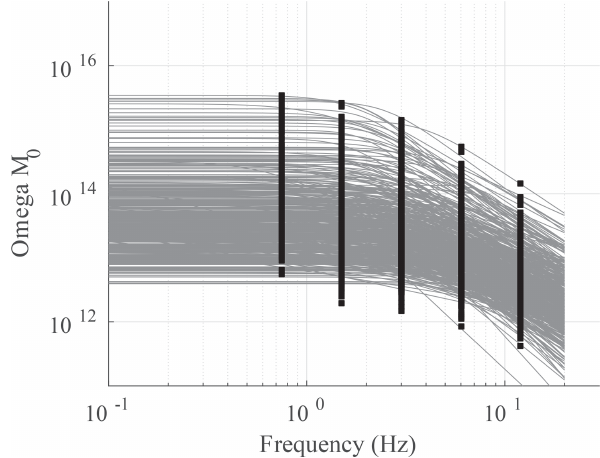
Figure 5. All individual observed (black squares) and predicted (gray curve) source displacement spectra observed at 72 stations from 487 local earthquakes in central Anatolia.